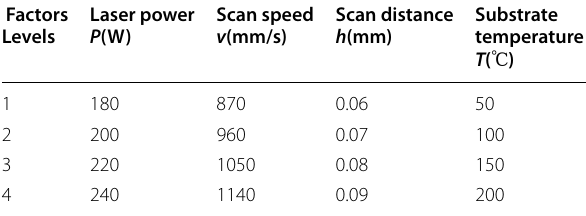
Table 3 Factors and levels of Taguchi